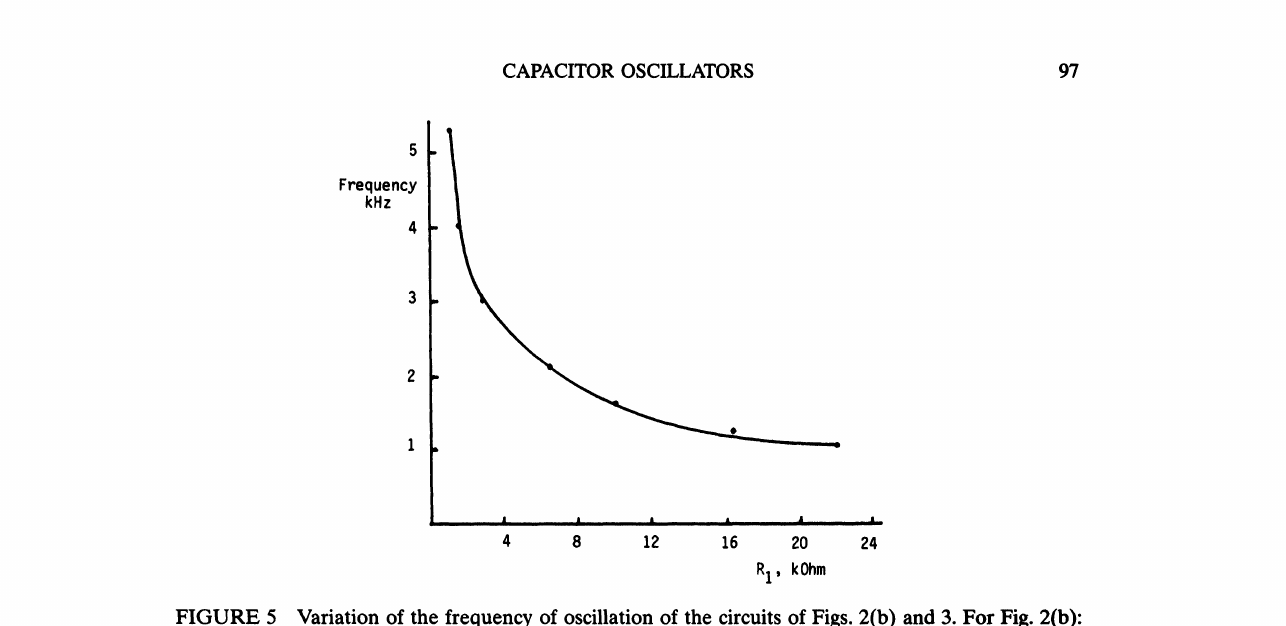
FIGURE 5 Variation of the frequency of oscillation of the circuits of Figs. 2(b) and 3. For Fig. 2(b): R2= 10k, C1 Ca= 10nF. ForFig. 3:R2= 10k, C2= Ca= 10nE